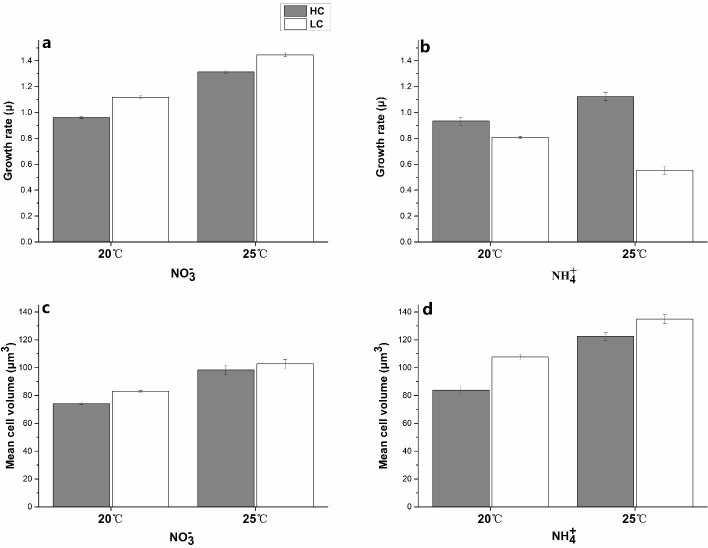
Specific growth rate (a, b) and cell volume (c, d) in NO3— and NH4+-grown cultures under HC (1000 μatm) and LC (400 μatm) at 20°C and 25°C. The values are the means and error bars are standard deviations for triplicate cultures at each treatment (p<0.05).